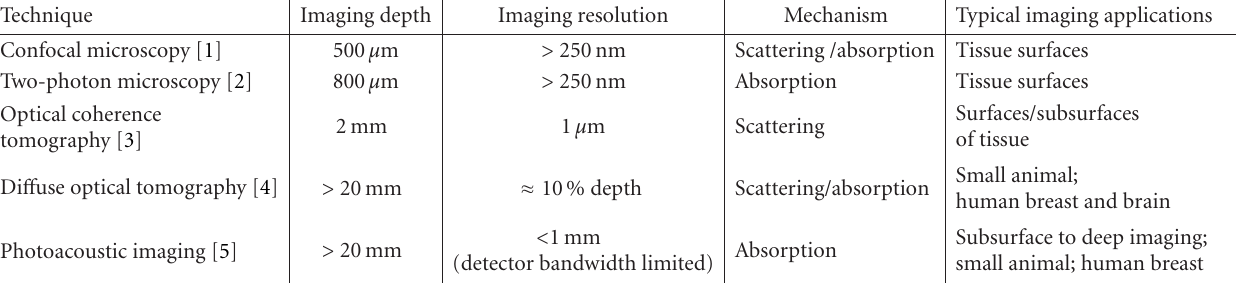
Table 2: Important optical imaging techniques that utilize absorption and scattering contrasts in biology and medicine. Technique Imaging depth Imaging resolution Mechanism Typical imaging applications